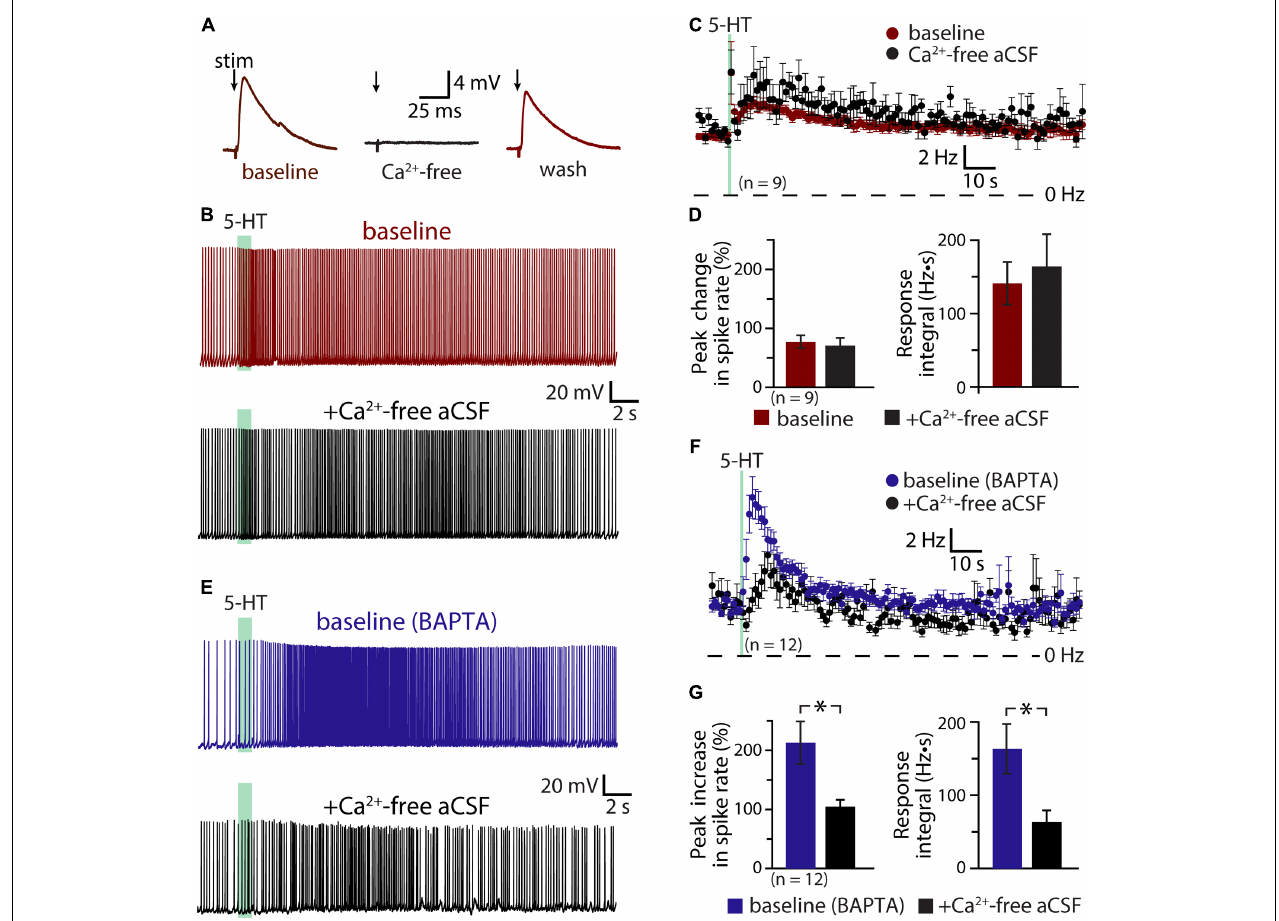
FIGURE 5 | Serotonergic excitation involves a calcium conductance. (A) Electrically evoked EPSPs (indicated by arrows) in a COM neuron in baseline conditions (red), after replacement of extracellular calcium with magnesium (black), and after return to normal calcium conditions (red). (B) Serotonergic responses in a COM neuron in control conditions (red trace) and after replacement of extracellular calcium with magnesium (black trace). Green bars indicate duration of 5-HT application. (C) Plots of mean instantaneous spike frequencies in baseline (red) and zero-calcium (black) conditions for 9 COM neurons. (D) Comparisons of peak increases in instantaneous spike frequencies (left) and response integrals (right) for COM neurons before (red) and after (black) removal of extracellular calcium. (E) Responses to 5-HT (green bars) in COM neurons recorded with 10 mM BAPTA in the whole-cell pipette, before (blue) and after (black) removal of extracellular calcium. (F) Plots of mean ( ± SEM) instantaneous spike frequencies for 12 BAPTA-filled COM neuron in baseline (blue) and calcium-free (black) conditions. (G) Comparisons of 5-HT response amplitudes (left) and integrals (right) in BAPTA-filled COM neurons in baseline (blue) and calcium-free (black)